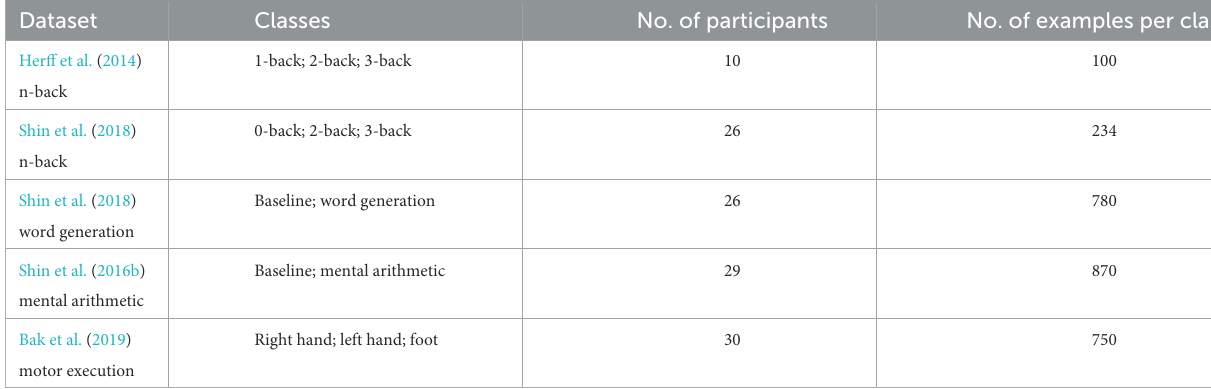
TABLE 1 Information about the datasets.